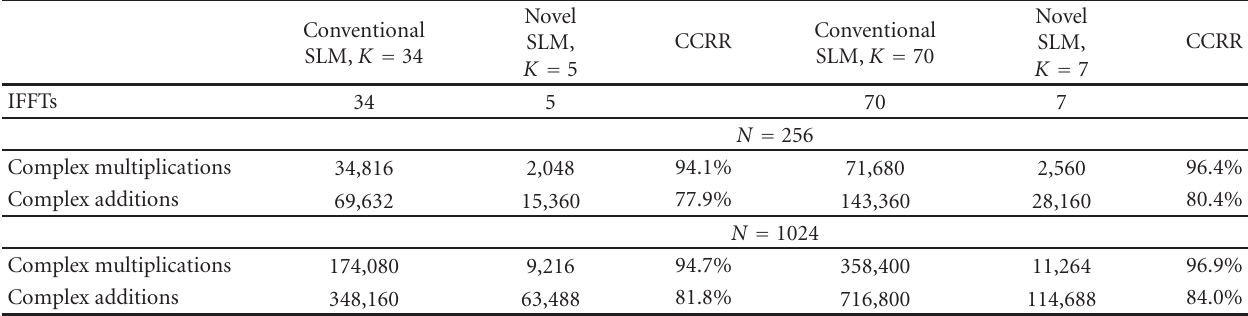
Table 2: Computational complexity of the conventional SLM and the novel SLM schemes when N = 256 and 1024.